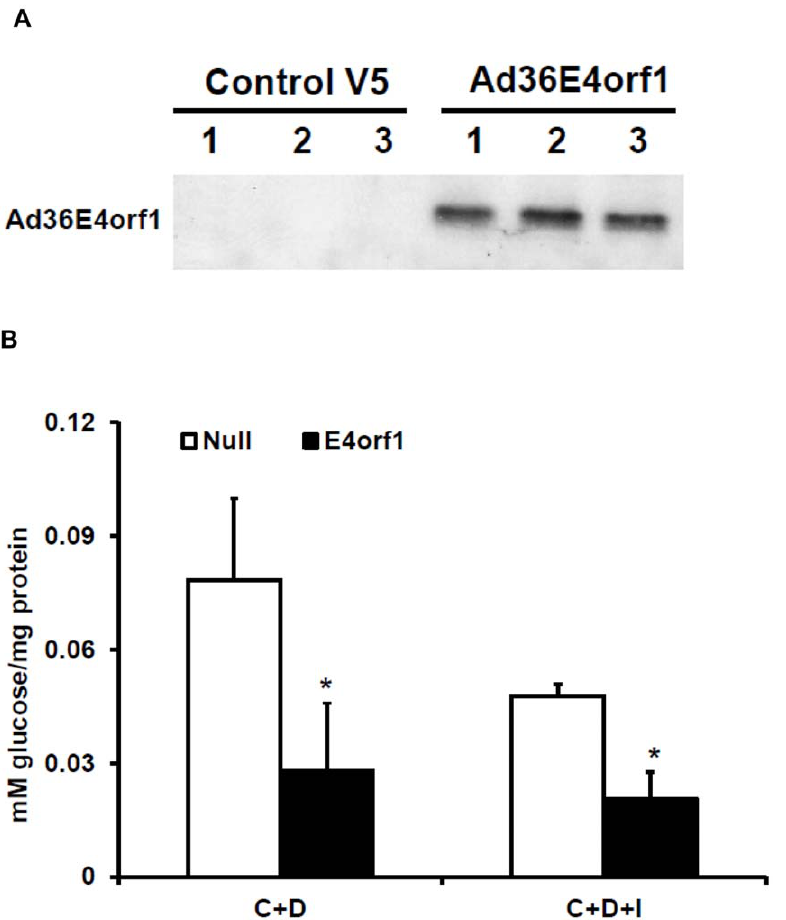
Figure 1. E4orf1 suppresses glucose output in the presence of gluconeogenic stimulators in HepG2. (A) Western blot showing Ad36 E4orf1 protein expression in HepG2 cells following transfection with V5-Ad36 E4orf1 plasmid DNA. (B) Glucose output by HepG2 cells following E4orf1 or null Vector transfection. Cells were stimulated with gluconeogenic cAMP (1 mM) (C) and Dexamethasone (500 nM) (D) in the absence or presence of insulin (I). Expressed as mean mM glucose per mg of protein, 6 SD. E4orf1 significantly suppresses glucose output in the basal and insulin stimulated conditions (p=0.0001 and 0.003, respectively).